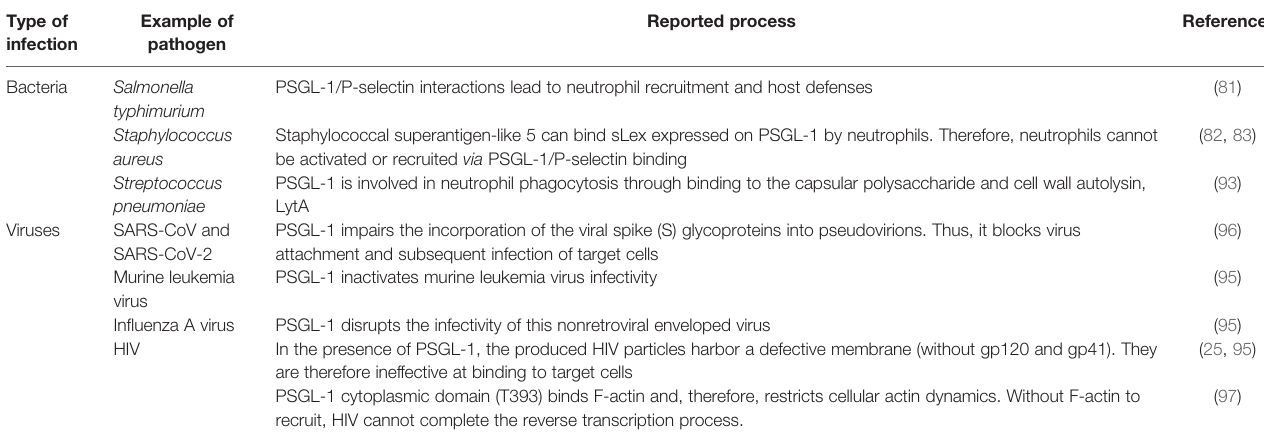
TABLE 2 | Summary of the roles of PSGL-1 in bacterial and viral infections.